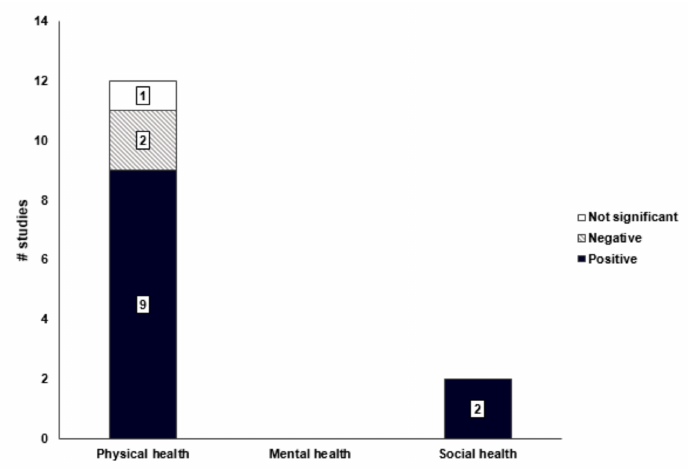
Figure 4. Associations between transportation infrastructure and health-related outcomes.